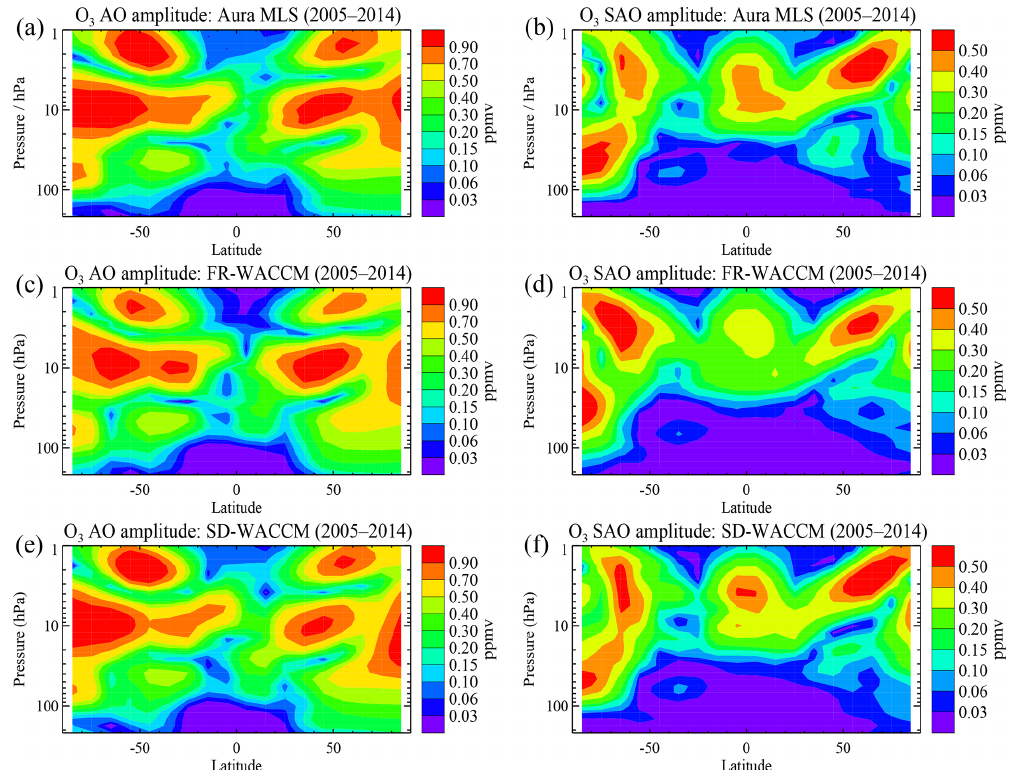
Figure 8. Amplitude of the stratospheric ozone annual cycle (a, c, e) and semiannual cycle (b, d, f) for Aura MLS (a, b) , FR-WACCM (c, d) , and SD-WACCM (e, f) , based on fits to time series from 2005 through